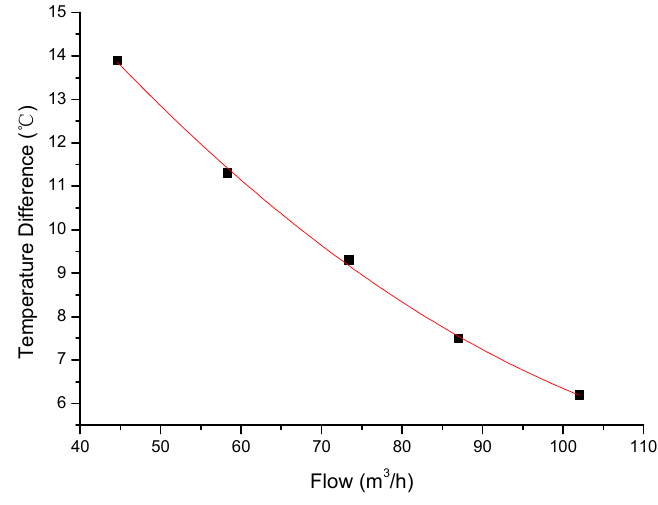
Figure 8. The fitting curve of flow-temperature difference.